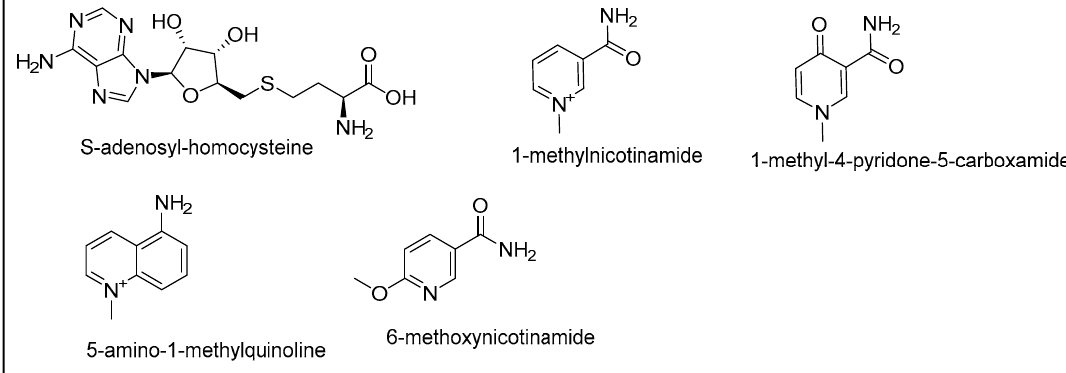
Figure 1. Known NNMT inhibitors.